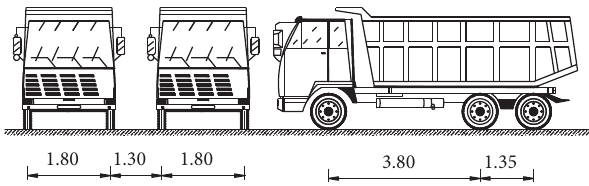
Figure 7: The wheel distances of loading vehicles (unit: